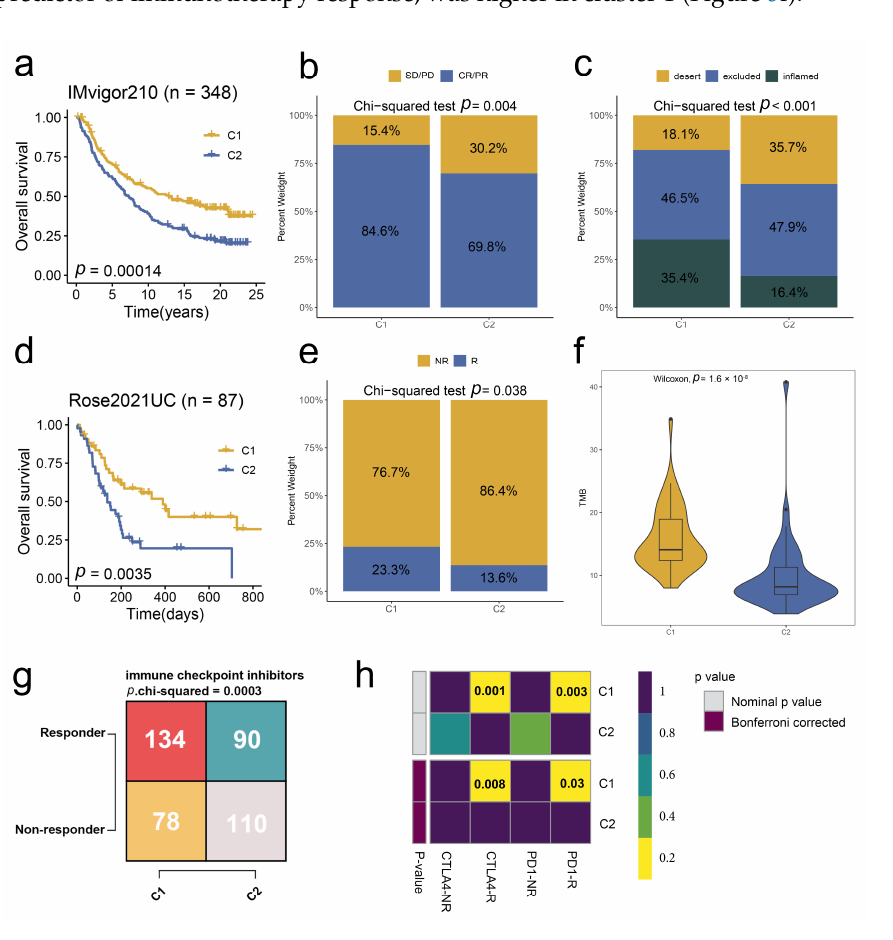
Figure 5. Stem. Sig. predicts immunotherapeutic responses in ICIs-treated BCa cohorts. ( a ) KM curves with log-rank test revealed the good prognosis of cluster 1. ( b ) The proportions of SD/PD and CR/PR between the two clusters. ( c ) The proportions of the immune phenotypes between two clusters. ( a – c ) Data were analyzed in the IMvigor210 dataset. ( d ) KM curves with log-rank test revealed the good prognosis of cluster 1. ( e ) The proportions of R and NR between the two clusters. ( f ) The distribution of TMB between two clusters. ( g ) A contingency table of the numbers of responders and non-responders to ICIs therapy between two clusters. Data were analyzed by the TIDE algorithm. ( h ) A contingency table between responses to ICIs therapy (anti-PD-1 and anti-CTLA-4) and two clusters based on the SubMap module of the GenePattern online